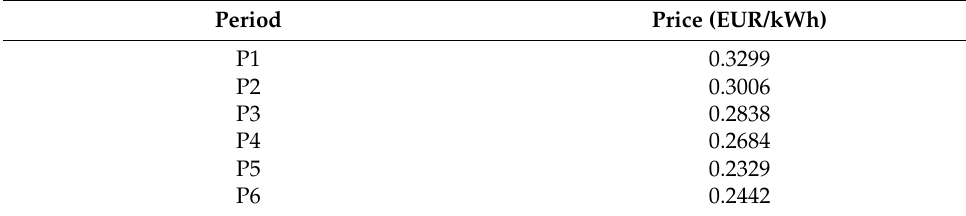
Table 4. Price of energy for each 3.0 TD tariff period.